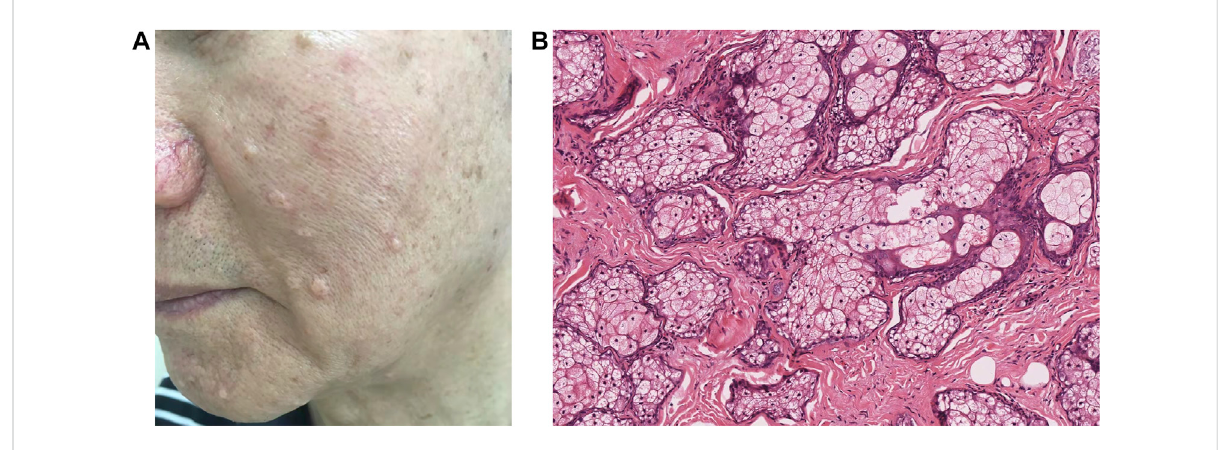
FIGURE 3 Skin-colored papules represent hyperplastic sebaceous glands disseminated on the face of an elderly patient. Clinically manifested as single or multiple pale yellow or skin color papules and nodules (A) , a great number of progenitor cells, and less mature sebocytes in histology (B)